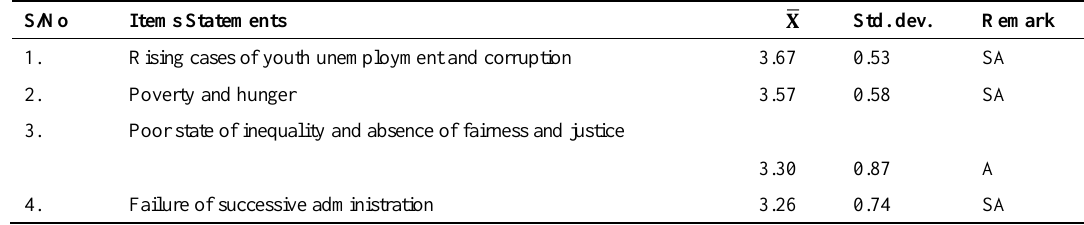
Table 1: Mean and Standard deviation of responses of respondents on the major factors responsible for insecurity in